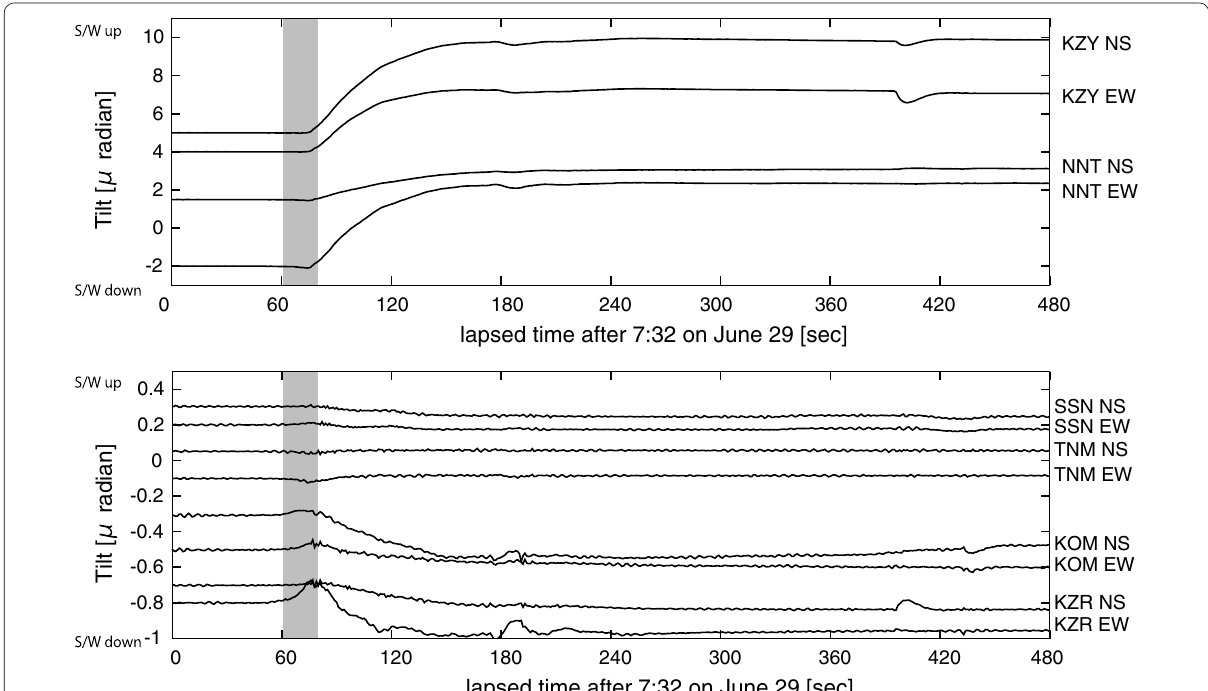
Fig. 3 Observed tilt records over an 8 min period starting at 7:32 a.m. on June 29, 2015. Note that the scale of tilt change is different for two plots. The site names and components are shown on the right-hand side of the figure. The sampling period was 1 s. The shaded areas represent reverse